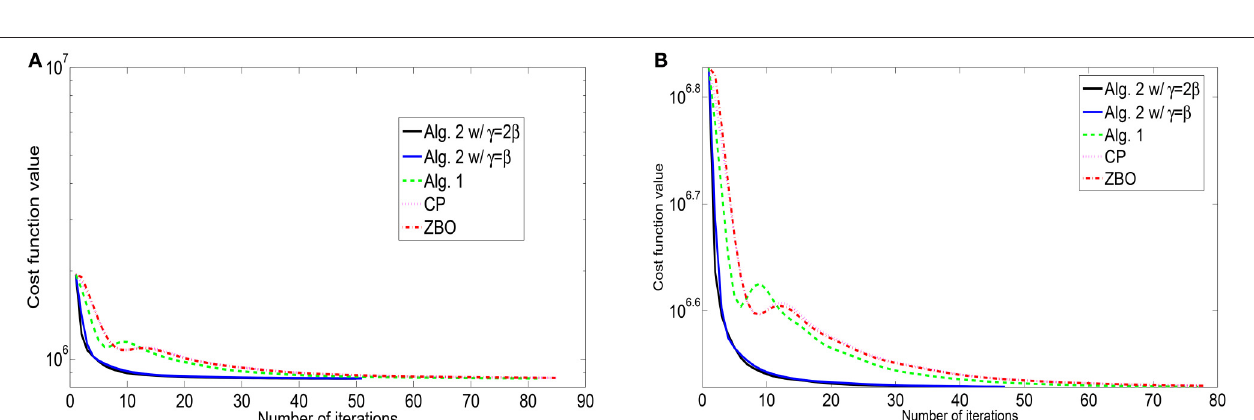
TABLE 3 | Numerical results for the L1-TV model for images blurred by the (21 , 10)-GBM. Method